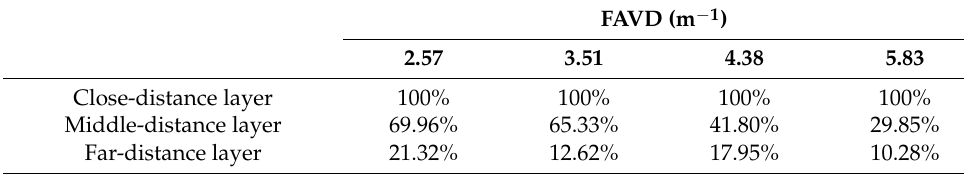
Figure 14. The canopy droplet deposition volume under different FAVDs. Table 12. Calculation results of the droplet penetration ratio in the canopy.